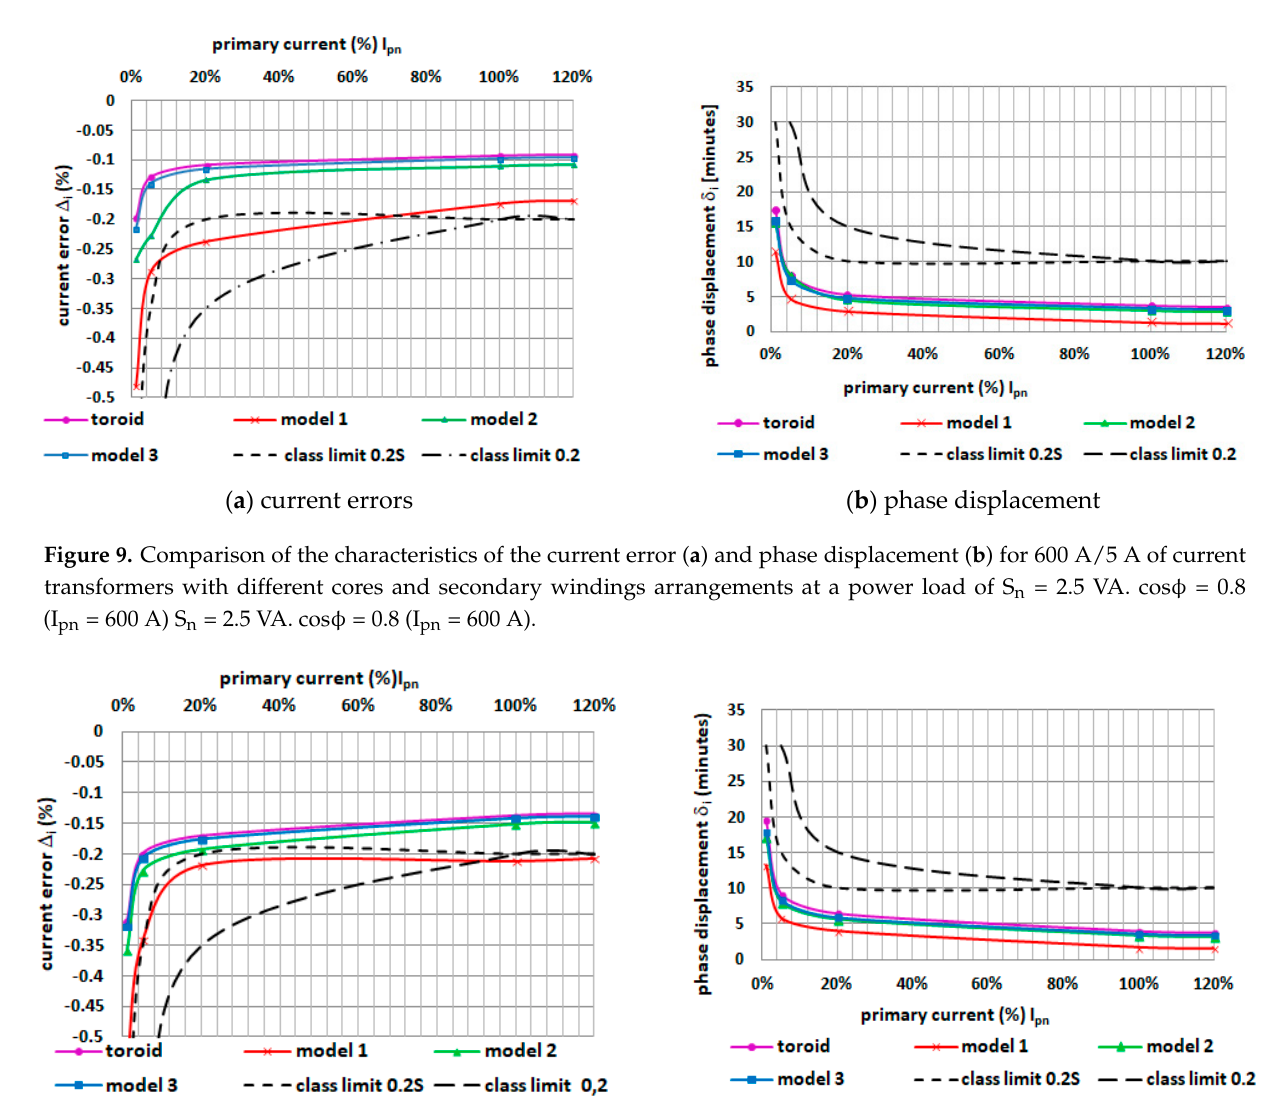
Figure 8. Toroidal current transformer type ELA 600 A/5 A class 0.2S ( a ) and its numerical model ( b ).